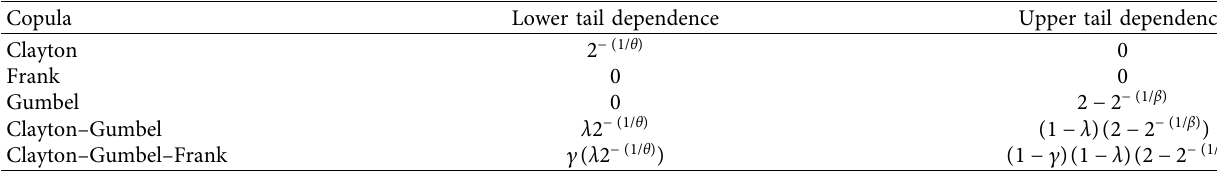
Table 2: Tail dependencies of models.